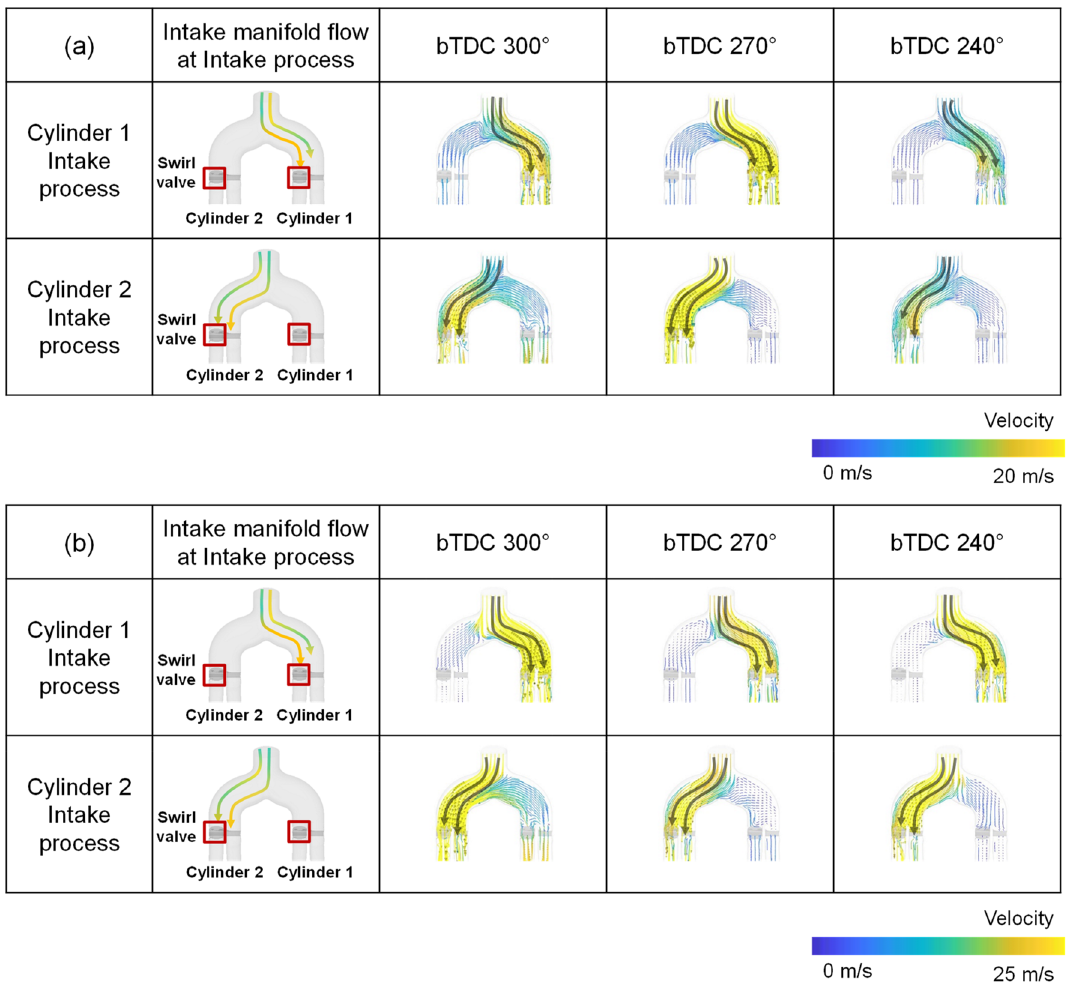
Figure 12. Cross-sectional velocity distribution for the straight manifold during intake process: ( a ) engine speed: 1500 rpm, intake pressure: 1 bar, ( b ) engine speed: 2000 rpm, intake pressure: 1